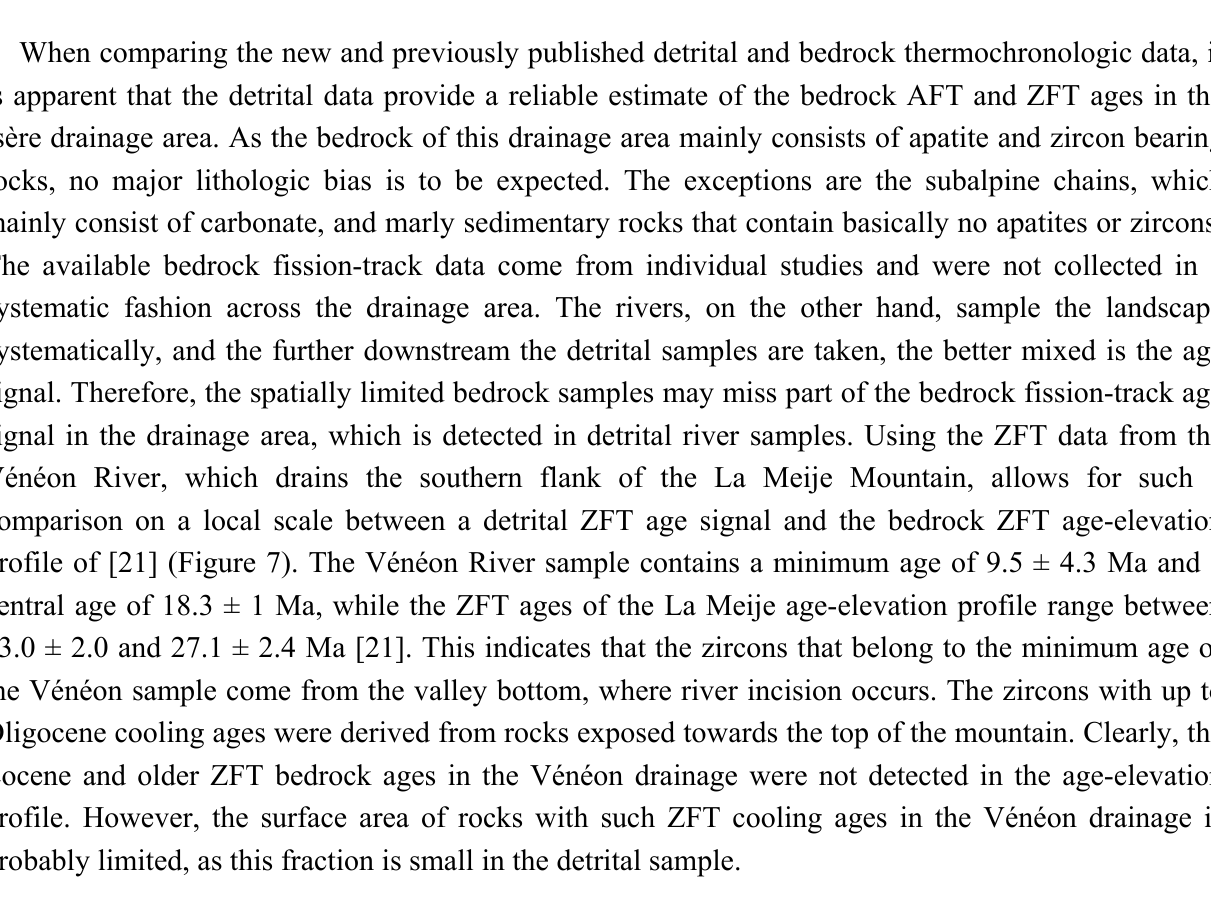
Figure 7. Vénéon River radial plot with minimum age estimate in comparison to the La Meije bedrock zircon fission-track data of